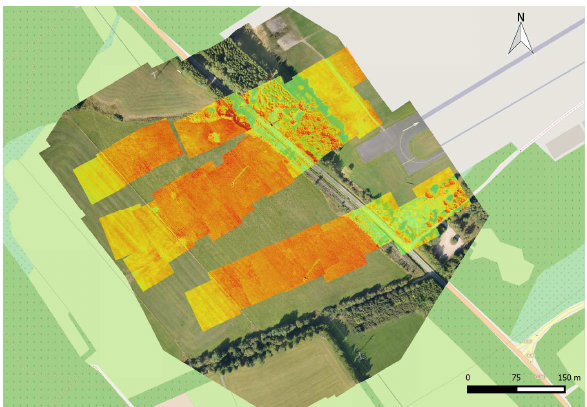
Figure 5. First test flight with VIS-RGB and the hyperspectral imager. A reference orthomosaic was created from the VIS- RGB images. From the acquired hyperspectral data the NDVI was calculated from two 10 nm spectral bands at 670 nm and 800 nm central wavelength (Thenkabail et al., 2002). The resulting NDVI images could only be matched, if possible at all, in several image stripes and were then matched with the orthophoto.